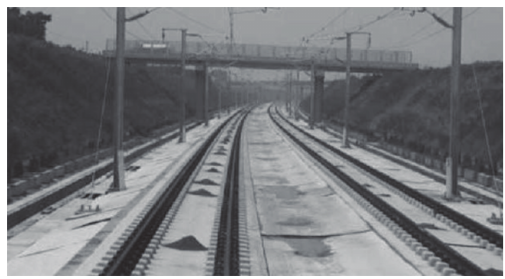
Figure 1: The cutting scenario in high-speed railway.